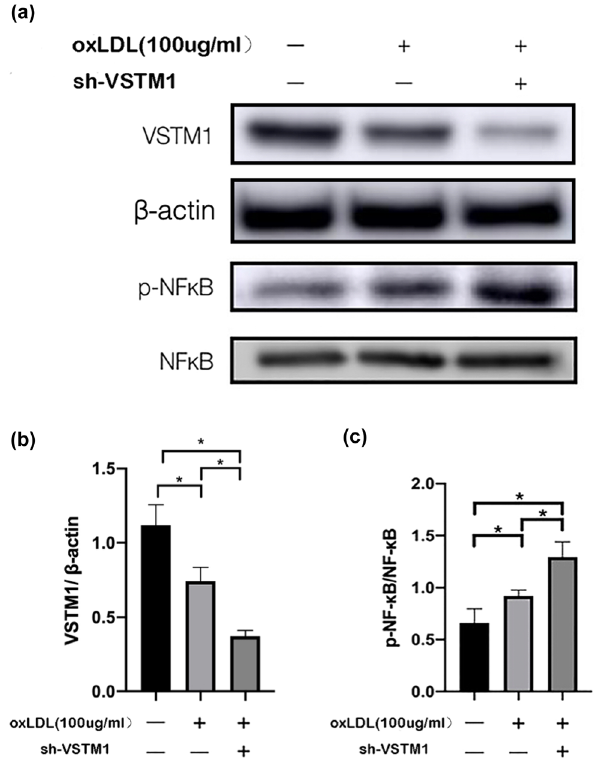
Figure 5: VSTM1 de fi ciency can induce the transcriptional activity of NF - κ B ( a – c ) . The expressions of VSTM1 and phospho - p65 in U937 cells were estimated by Western blotting analysis. U937 cells were treated with ox - LDL ( 100 µg/mL ) and transfected with VSTM1 + ox - LDL ( 100 µg/mL ) , and the NC group was used as the controls ( dif - ference between groups, * p < 0.05, n = 5 ) . Statistical analysis was performed using Pearson chi - square test ( n ≥ 5 ) or Fisher ’ s exact test ( n ＜ 5 ) with subsequent multiple comparisons using Chi - square with Bonferroni correction for categorical variables. One - way ANOVA with subsequent post hoc multiple comparisons was used for continuous variables with the Student – Newman – Keuls